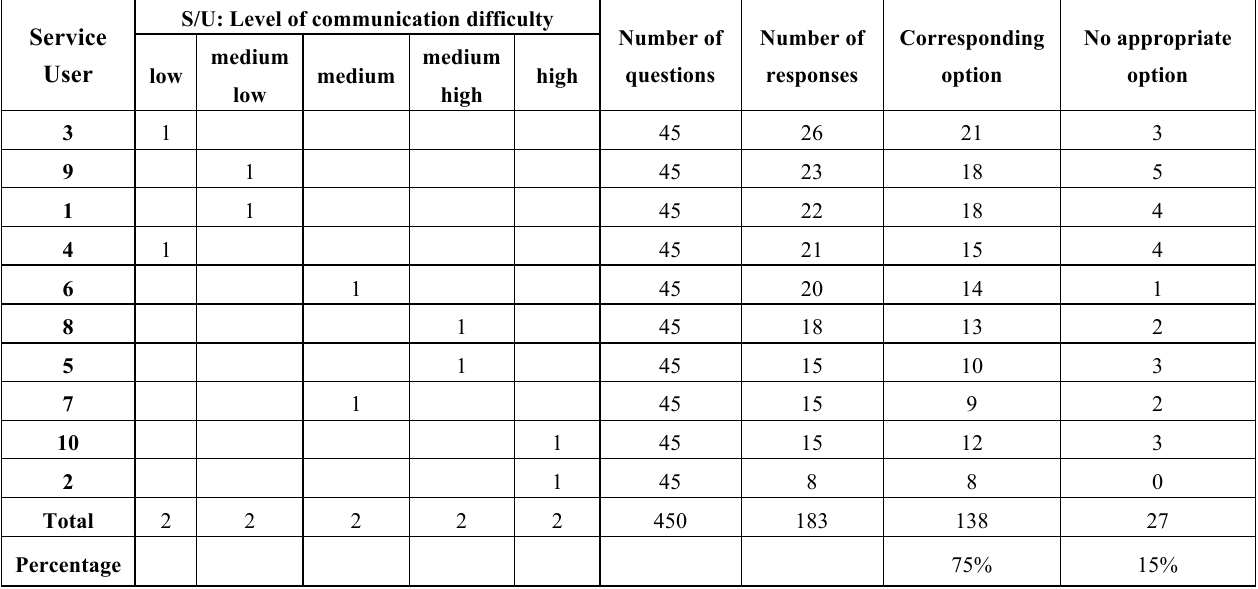
Table 3. Questionnaire responses for each service user in relation to their level of communication